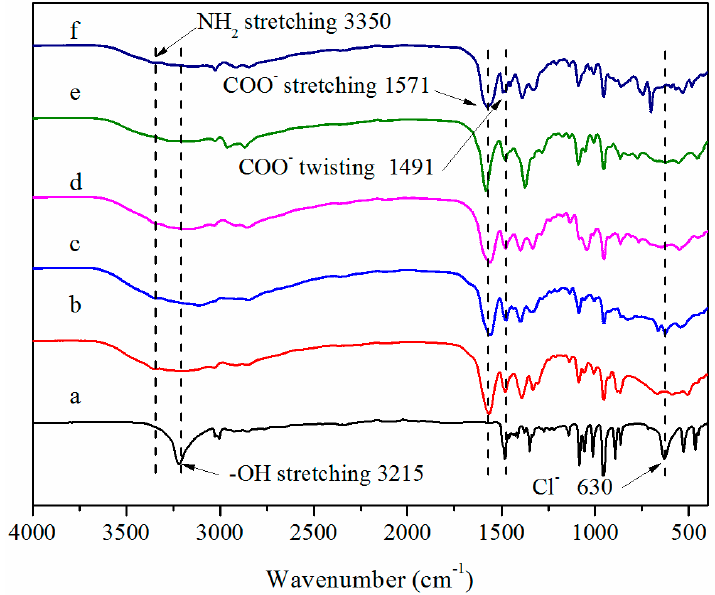
Figure 4. Fourier transform infrared spectroscopy spectra of (a) ChCl, (b) ChGly,(c) ChHis, (d) ChSer, (e) ChPro, and (f) ChPhe.